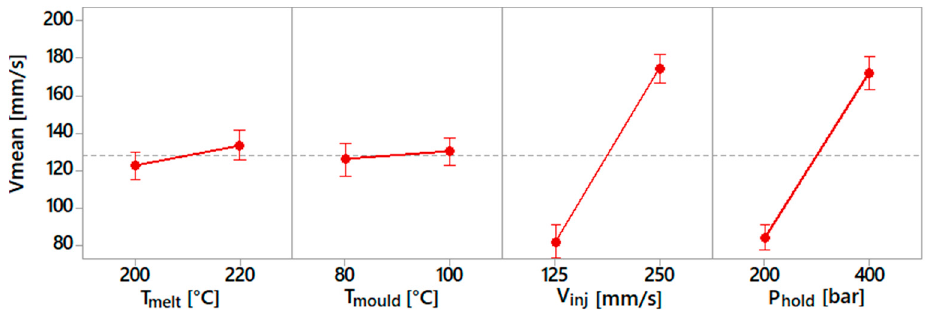
Figure 9. Main effect plot for mean injection speed. Figure 9. Main e ff ect plot for mean injection